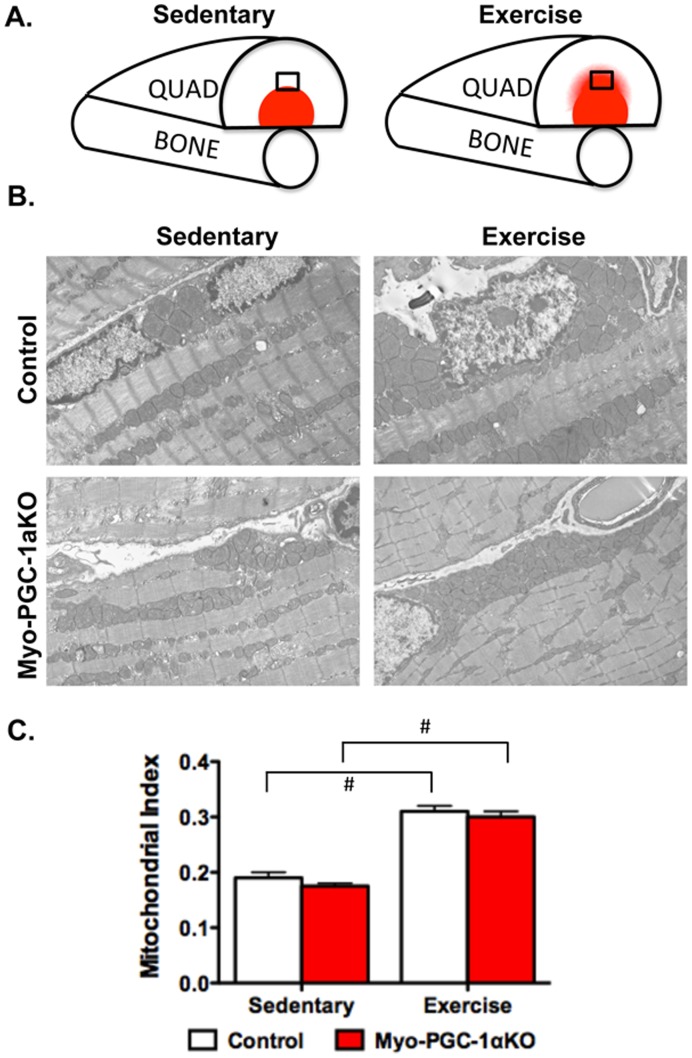
Exercise induced mitochondrial biogenesis in Myo-PGC-1α animals.A.) Schematic of mid-portion of muscle recruited in response to exercise. Shading represents oxidative portion of muscle. Black square represents region of interest (ROI) used for studies B.) Transmission electron micrographs (TEM) of transverse sections of recruited ROI of quadriceps before and after 2-week voluntary wheel run C.) Quantification of mitochondrial density from TEMsof the Myo-PGC-1αKO (red bar) and littermate controls (white bar).n>4 fields from 4 animals per group. Error bars indicate s.e.m.; n >3 per group in all panels. * - P<0.05 compared to control.